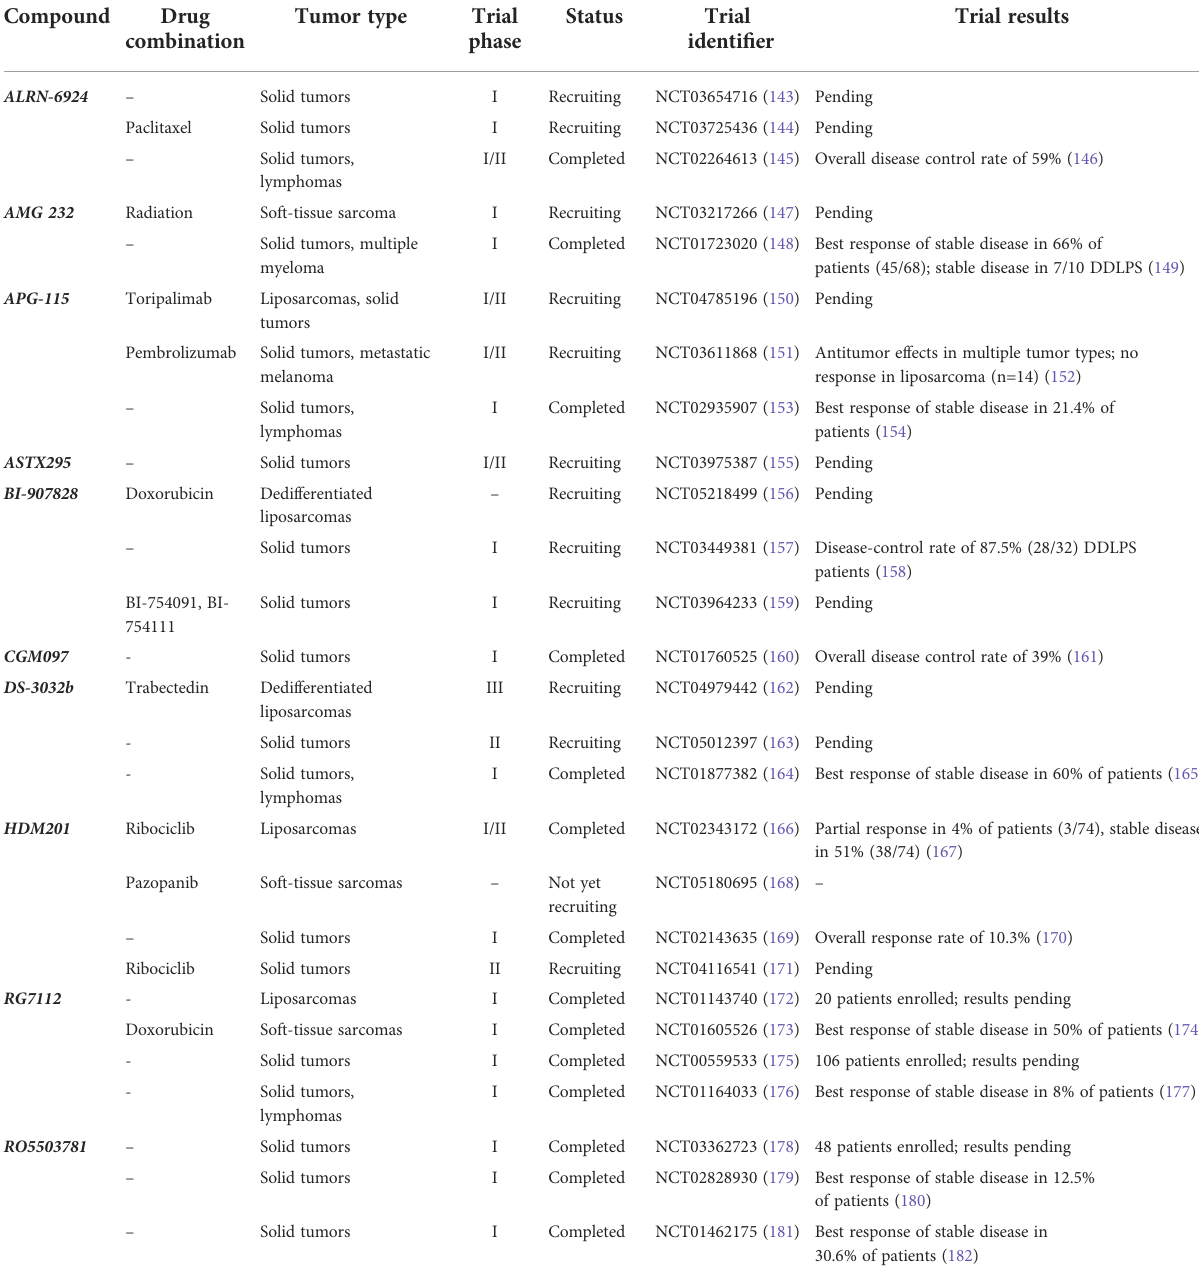
TABLE 1 List of clinical trials investigating MDM2 inhibition in liposarcomas or other solid